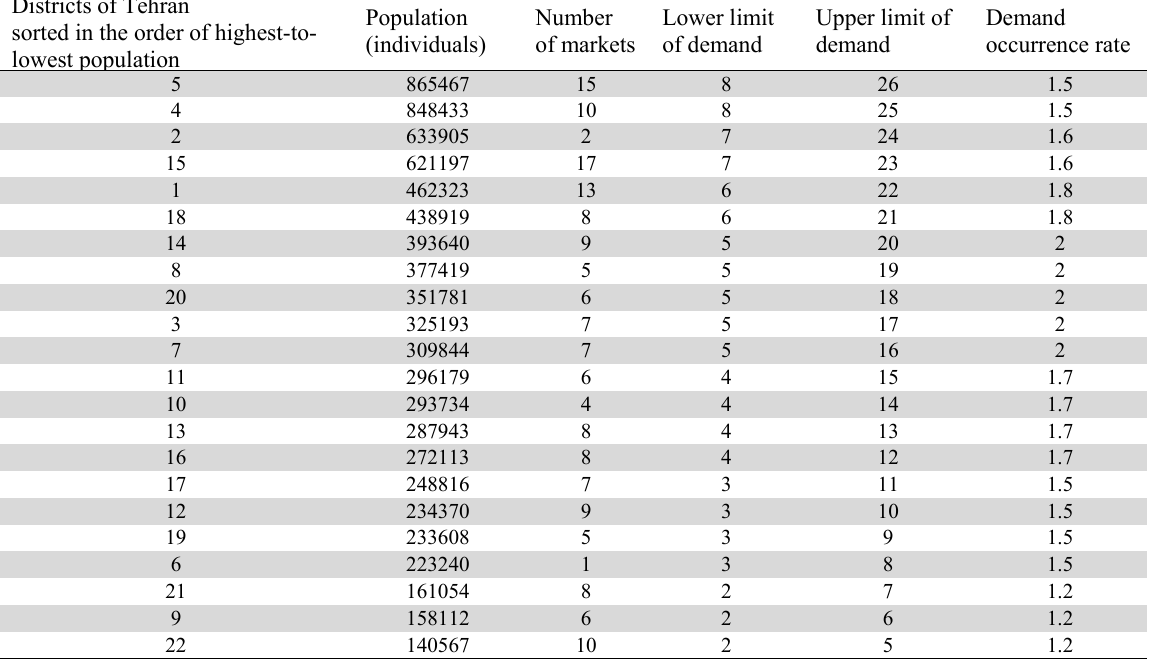
Demand parameters Districts of Tehran sorted in the order of highest-to- lowest population